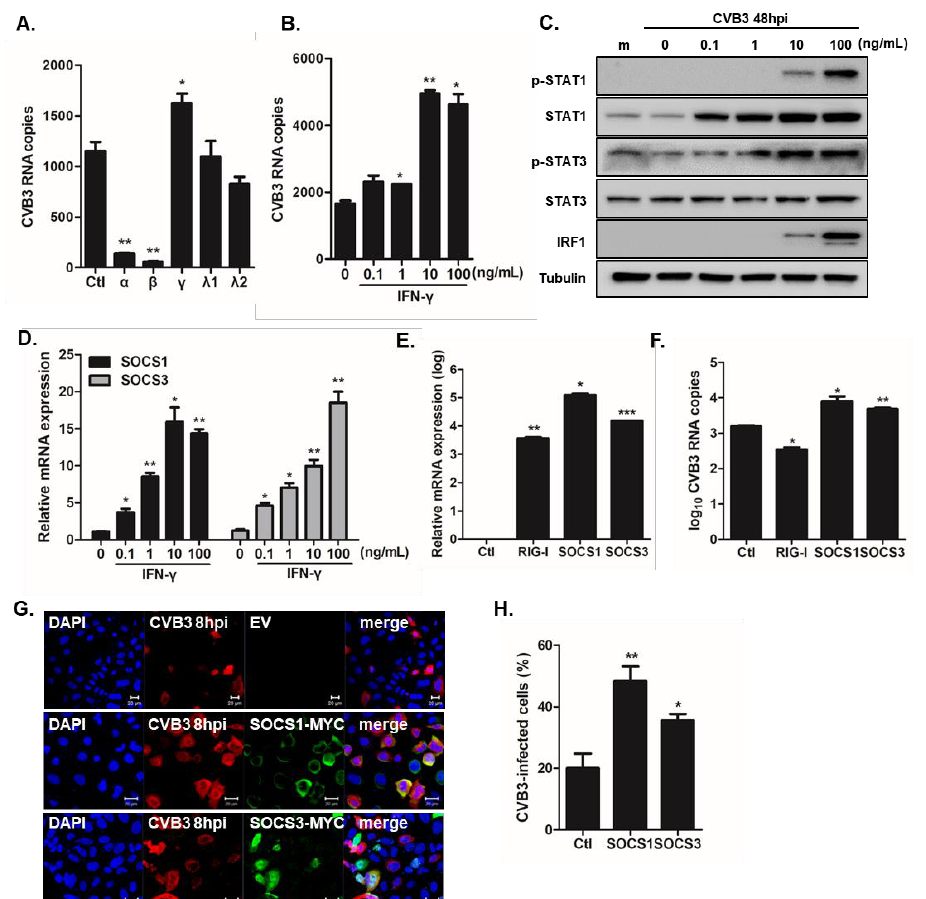
Figure 5. Type II interferon (IFN) signaling results in enhanced viral replication via upregulation of suppressor of cytokine signaling (SOCS)1 and SOCS3. ( A ) Recombinant human IFN-α (10 ng/mL), IFN-β (10 ng/mL), IFN-γ (10 ng/mL), IFN-λ1 (100 ng/mL), and IFN-λ2 (100 ng/mL) were added to hNPCs. The next day, cells were infected with CVB3 (MOI 5) and viral RNA expression was measured by RT-PCR. Data are shown as means ± SEM of three independent experiments. ( B – D ) hNPCs were treated with various doses of IFN-γ overnight, followed by CVB3 infection (MOI 5). ( B ) CVB3 copy number was determined ( C ) The protein levels of IFN-γ downstream signaling pathways, such as pSTAT1/STAT1, pSTAT3/STAT3, and interferon regulatory factor 1 (IRF1) were measured by western blotting. ( D ) RT-PCR was performed to measure relative SOCS1 and SOCS3 mRNA levels. * p < 0.05; ** p < 0.01; *** p < 0.001 versus mock-infected control cells. ( E , F ) HeLa cells were transfected with empty vector (EV), SOCS1-MYC tag, or SOCS3-MYC tag encoding plasmids for 24 h. The next day, cells were infected with CVB3 (MOI 1) for 8 hpi. Transfection efficiency was confirmed by measuring each gene expression level. Changes in the transcriptional expression of CVB3 vRNA were measured using RT-PCR. Transcript expression levels were calculated in relation to the expression level of β -actin and expressed as a fold-change in comparison to the expression level in EV-transfected control cells. * p < 0.05 versus mock-infected EV-transfected cells. ( G , H ) HeLa cells were transfected with EV, MYC-SOCS1, or MYC-SOCS3 encoding plasmids for 24 h and infected with CVB3 for 8 h. Cells were immunostained with anti-Coxsackievirus B3 antibody and anti-MYC antibody to detect SOCS proteins. CVB3 is indicated in red and cell nuclei are stained blue. The images are representative of three independent experiments. Scale bar represents 20 µ m. CVB3-infected cells were counted and presented as % in the